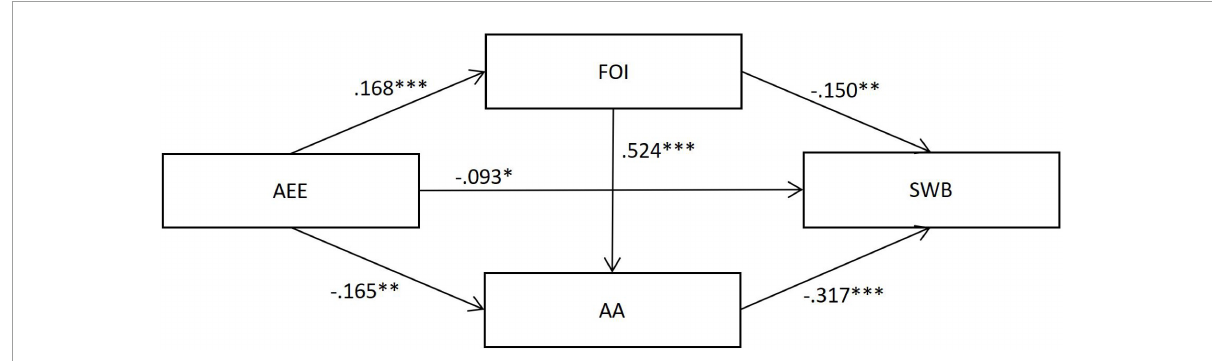
FIGURE1 The structural equation model regarding the mediating effects of fear of intimacy and attachment avoidance on the association between ambivalence over emotional expression and subjective wellbeing. Standardized regression coefficients are presented after controlling for age and gender. ∗∗∗ p < 0.001, ∗∗ p < 0.01, ∗ p <